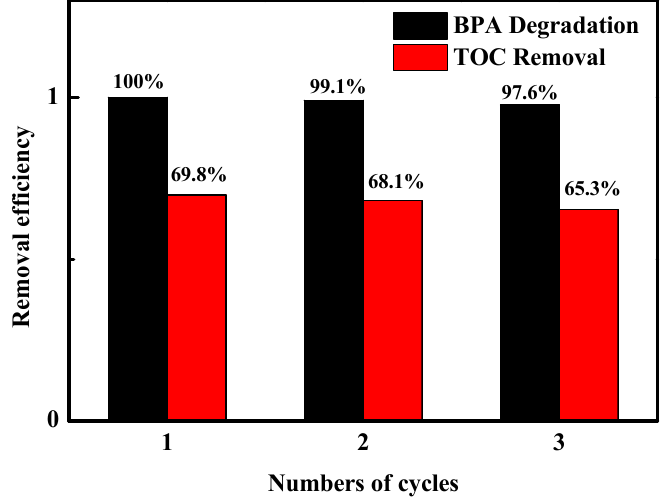
Figure 9. Cycling runs in the heterogeneous photo-Fenton system with FePcS–PMA–LDH.